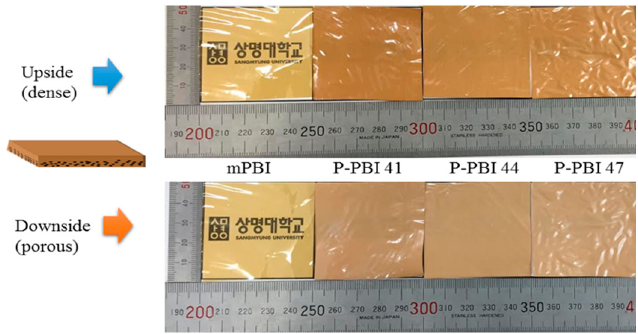
Figure 2. Photographs of non-porous and asymmetrically porous PBI membranes.